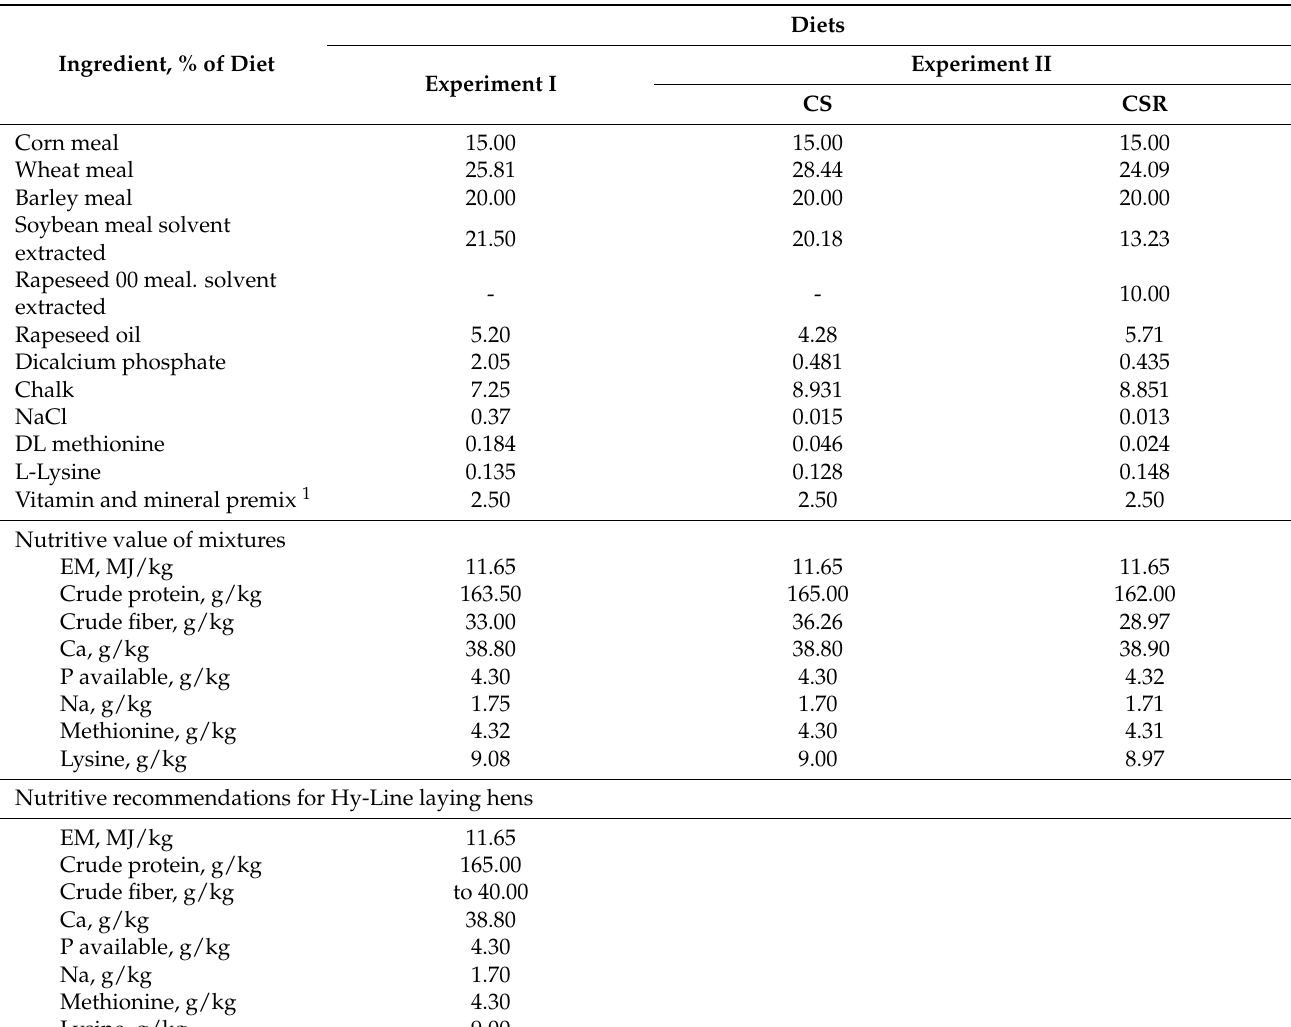
Table 2. Basal composition of the experimental diets in both